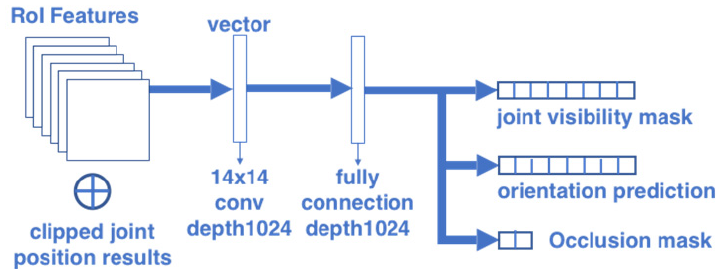
Figure 11. Orientation ‐ occlusion branch combined with joint position (for Figure 8a,b).